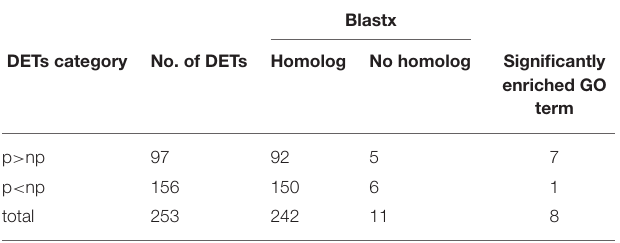
TABLE 2 | Differential expression analysis in the anthers (collected from the bud size, 11–14mm) of pollen-sterile (np) and fertile (p) plants with the criteria of FDR < 0.05 and | logFC| > 10, best-hit blastx homology search, and GO analysis.